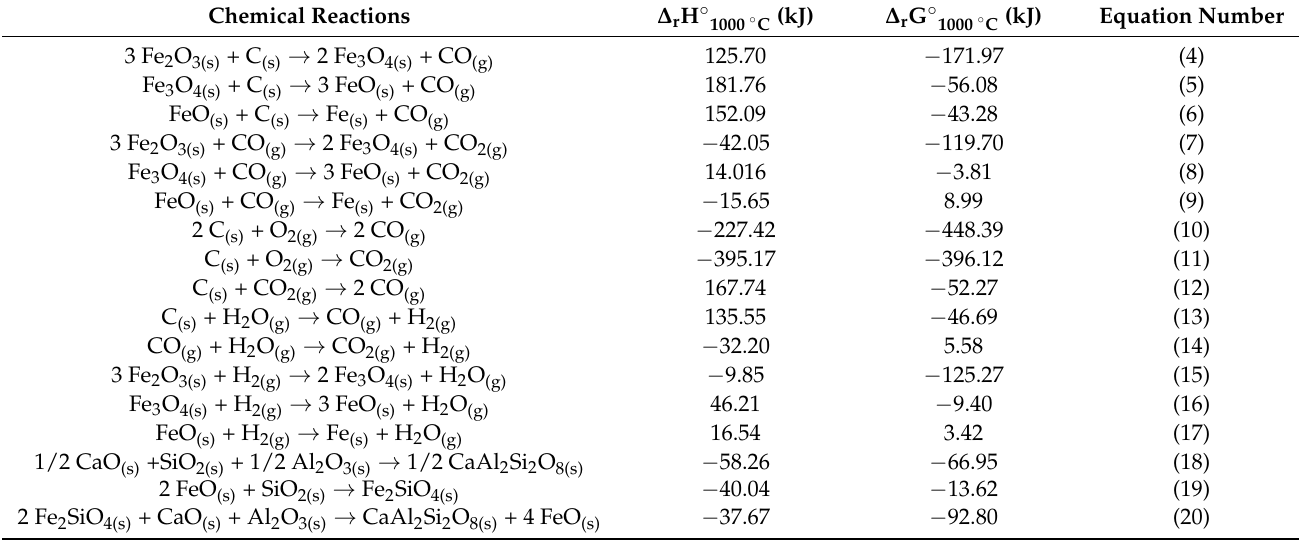
Table 5. Selected reactions and thermodynamic data of iron oxide reductions with various reducing